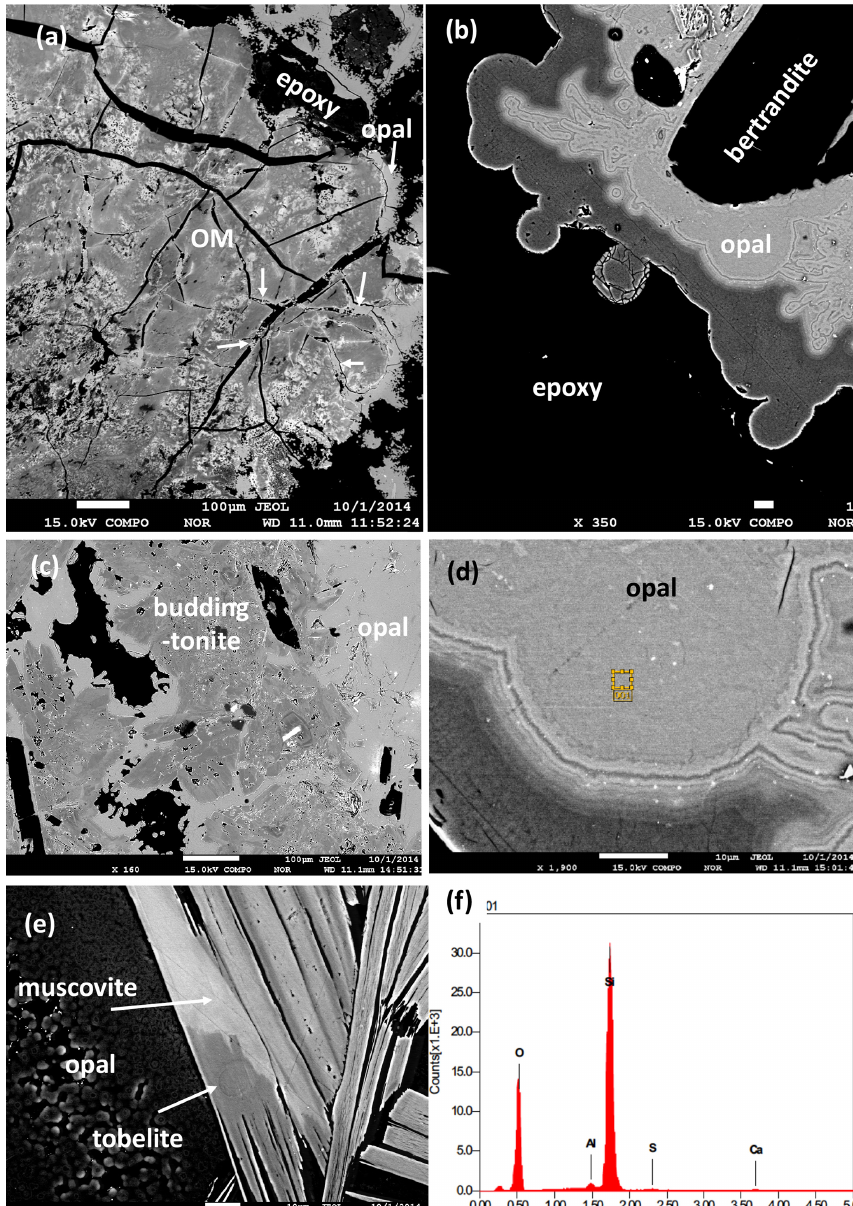
Figure 7. BSE images of black opal from the pseudomorph. (a) Organic matter with differences in BSE contrast due to different content of Zr and other high field strength elements; opal (arrow) occurs in cracks and on the rim. (b) Zoned opal surrounding bertrandite. (c) Opal surrounding buddingtonite. (d) Detail of zoned opal with nanometer-sized inclusions (bright contrast). Rectangle indicates position of EDS analysis. (e) Opal next to muscovite with different BSE contrast due to different tobelite component. (f) EDS analysis of black opal with traces of Al, S, and